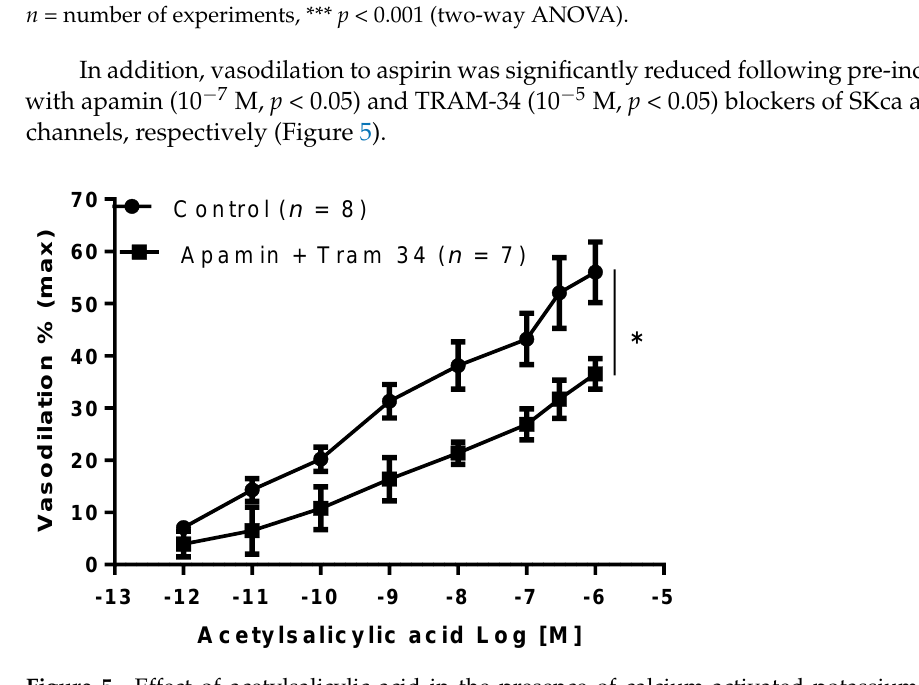
Figure 5. Effect of acetylsalicylic acid in the presence of calcium-activated potassium channel inhibitors. Acetylsalicylic acid was tested on phenylephrine preconstricted mesenteric arteries isolated from gravid rats in the absence (Control) or in the presence of both calcium-activated potassium channel small (Sk Ca ,) and intermediate (IK Ca ) inhibitors Apamin (10 − 7 M) and TRAM-34 (10 − 5 M), respectively. Data are reported as mean ± SEM, n = number of experiments, * p < 0.05 (two-way ANOVA).